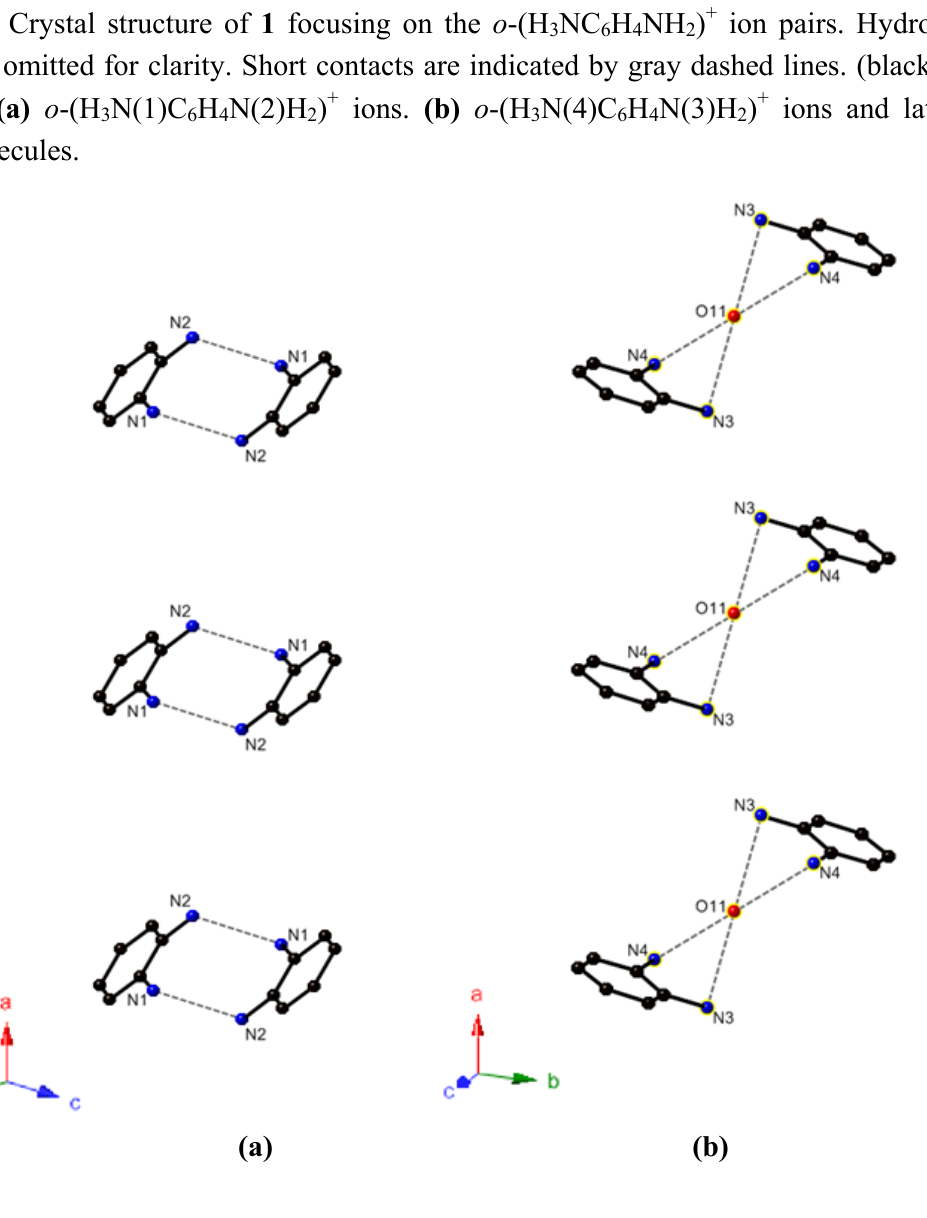
NC H NH ) + ion pairs. Hydrogen 3 6 4 2 N(4)C H N(3)H ) + ions and lattice 3 6 4 2